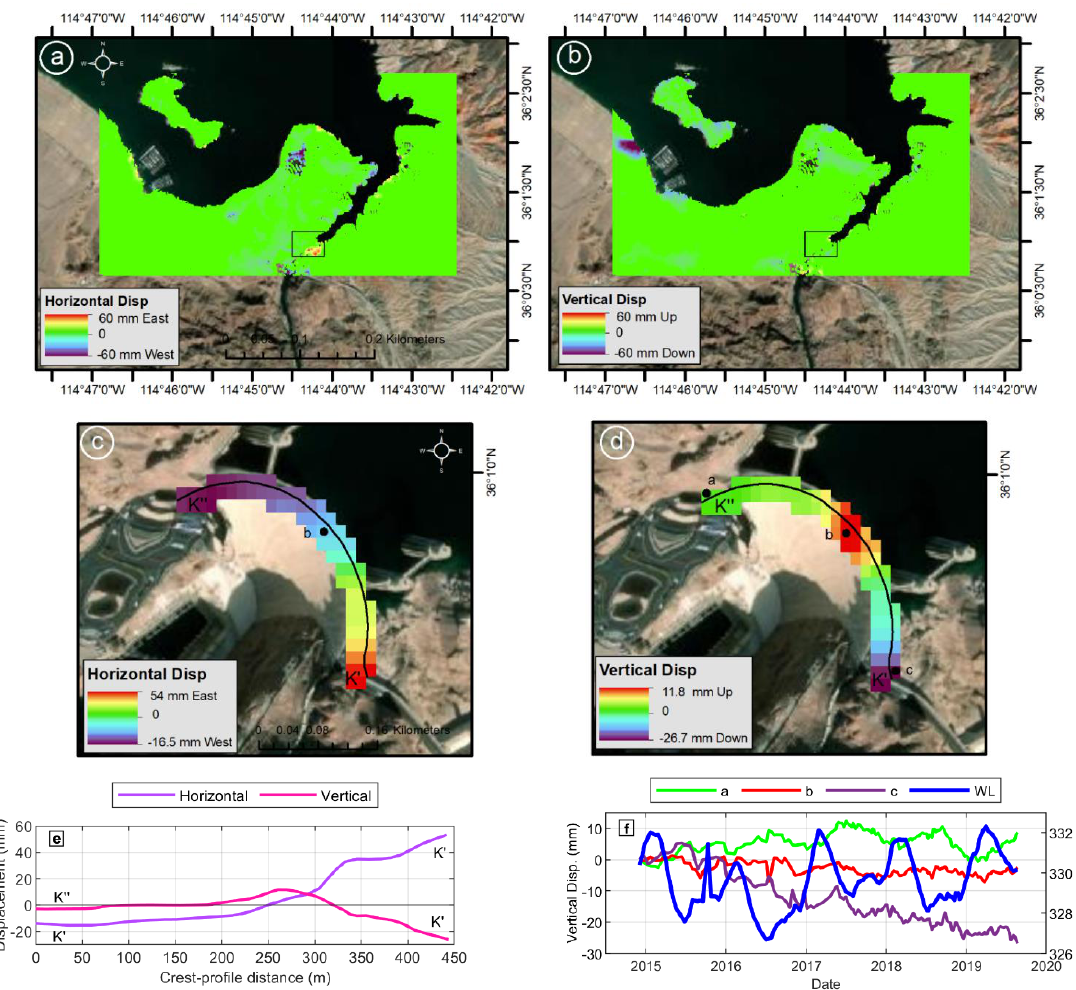
Figure 9. Horizontal and vertical displacements of the Hoover Dam during the S1 period. Regional ( a ) horizontal and ( b ) vertical displacement maps, with focus on the dam site—( c ) horizontal and ( d ) vertical displacements, respectively. ( e ) Total horizontal and vertical displacements along the crest (from point K’ to K’’) and ( f ) time-series of water level and the vertical displacements of the buttresses and the points ‘a’, ‘b’, and ‘c’, along and over the crest (Figure 9d).